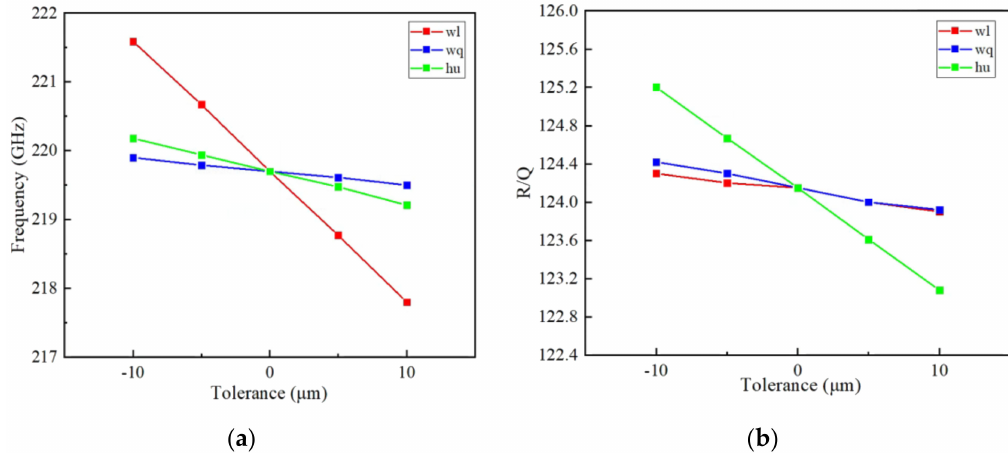
Figure 4. Influence of the fabrication tolerance of ∆ wq, ∆ wl and ∆ hu on the high frequency characteristics: ( a ) sensitivity of frequency and ( b ) sensitivity of R / Q